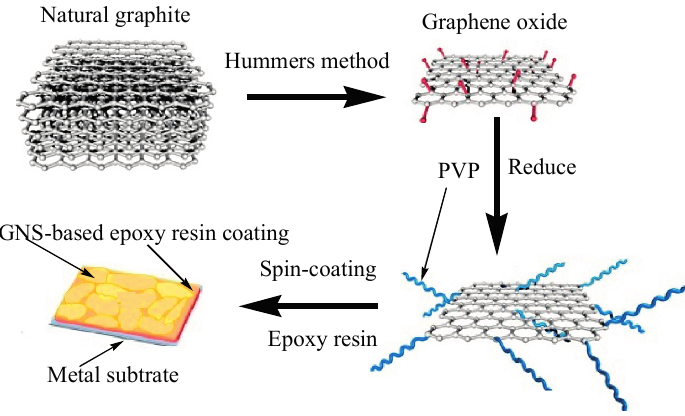
Scheme 1. Synthetic process of GNS-based epoxy resin